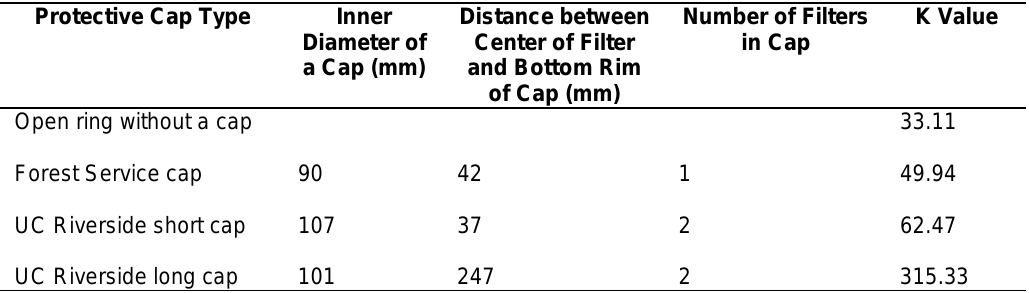
Characteristics of Tested Protective Caps and K Values (Slope of Calibration Curves) for HNO 3 Concentration